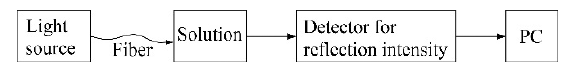
Fig. 9. Schematic of the home-made measuring